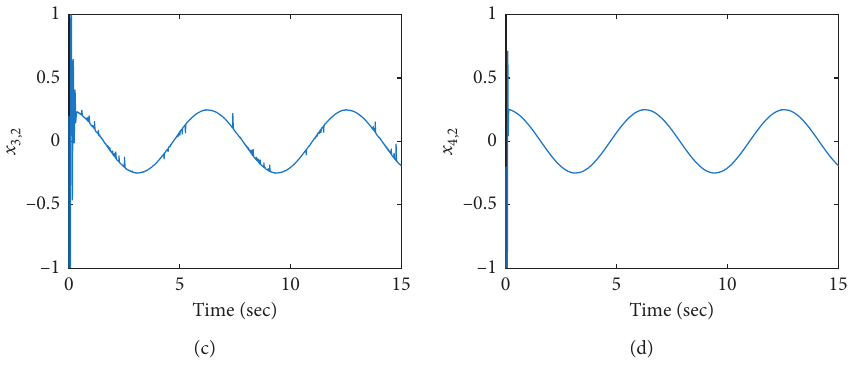
Figure 8: The states x i, 2 of the four followers.